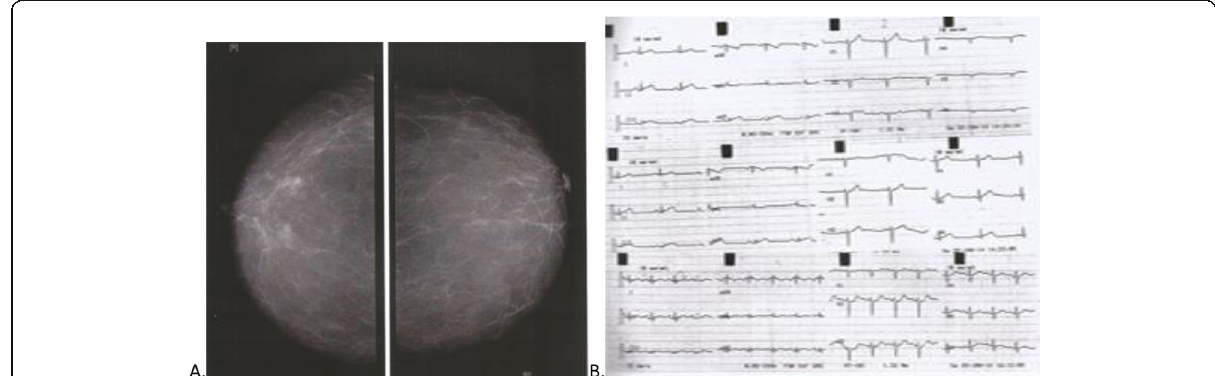
Fig. 5 51-year-old female patient known DM, diagnosed with inferior STEMI by ECG, cardiac enzymes and echocardiogram. Bilateral breast mammography CC view showed no evidence of BAC. b ECG of an inferior STEMI. Example of CAD patient without BAC